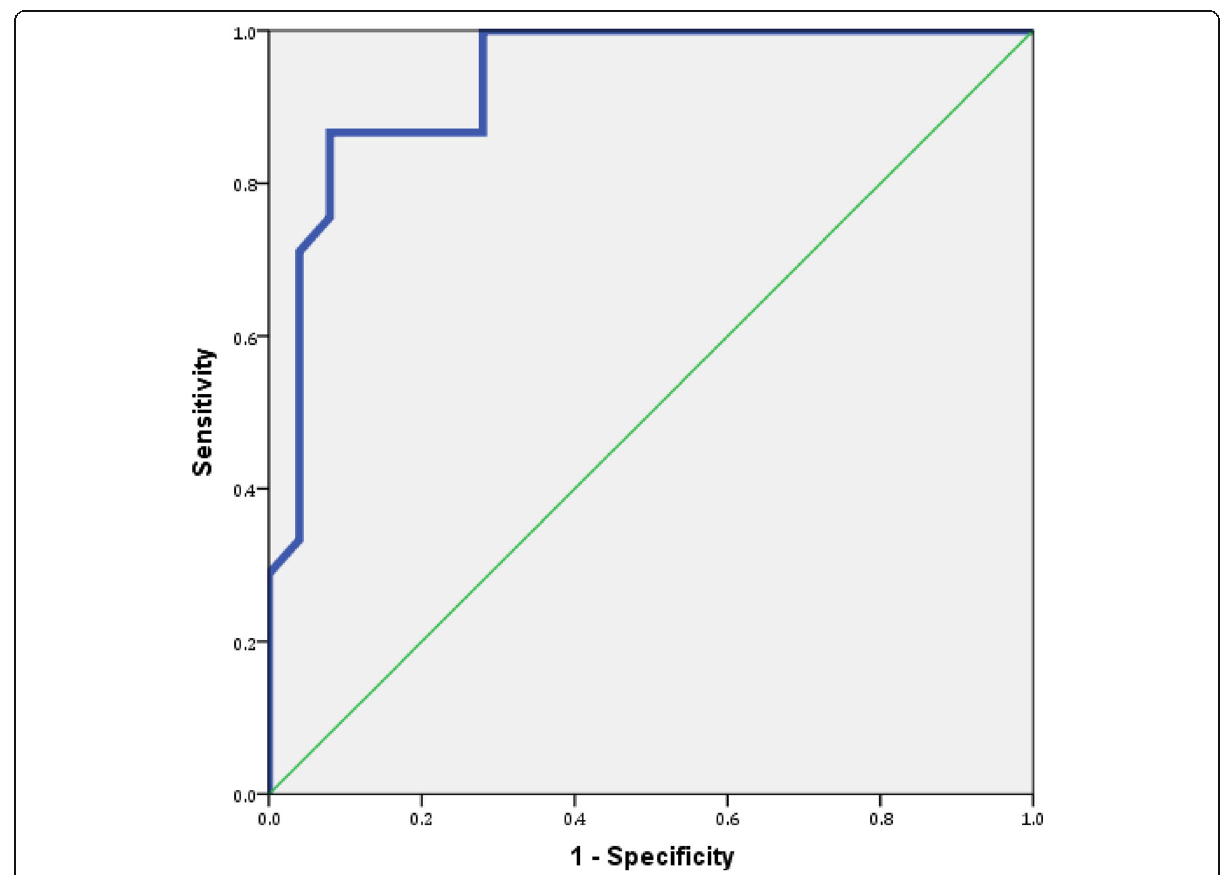
Fig. 4 ROC curve showing performance of FENO in diagnosis of steroid response among the studied